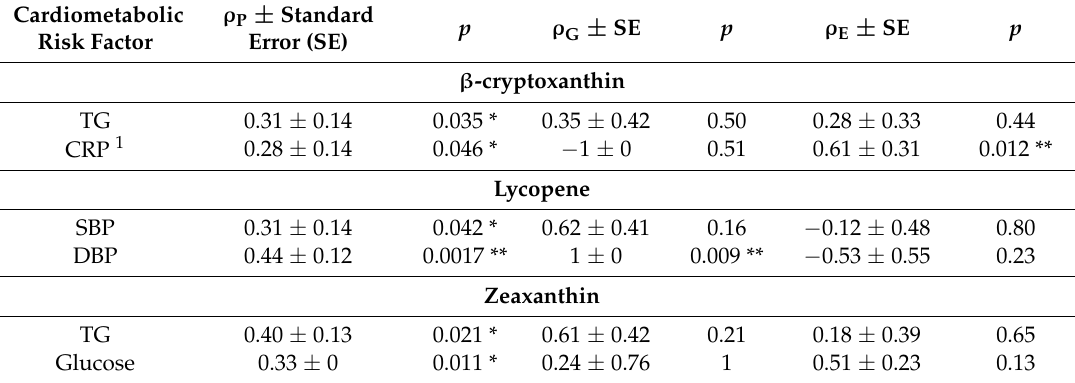
Significant phenotypic, genetic, and environmental correlations between carotenoid concentrations and cardiometabolic risk